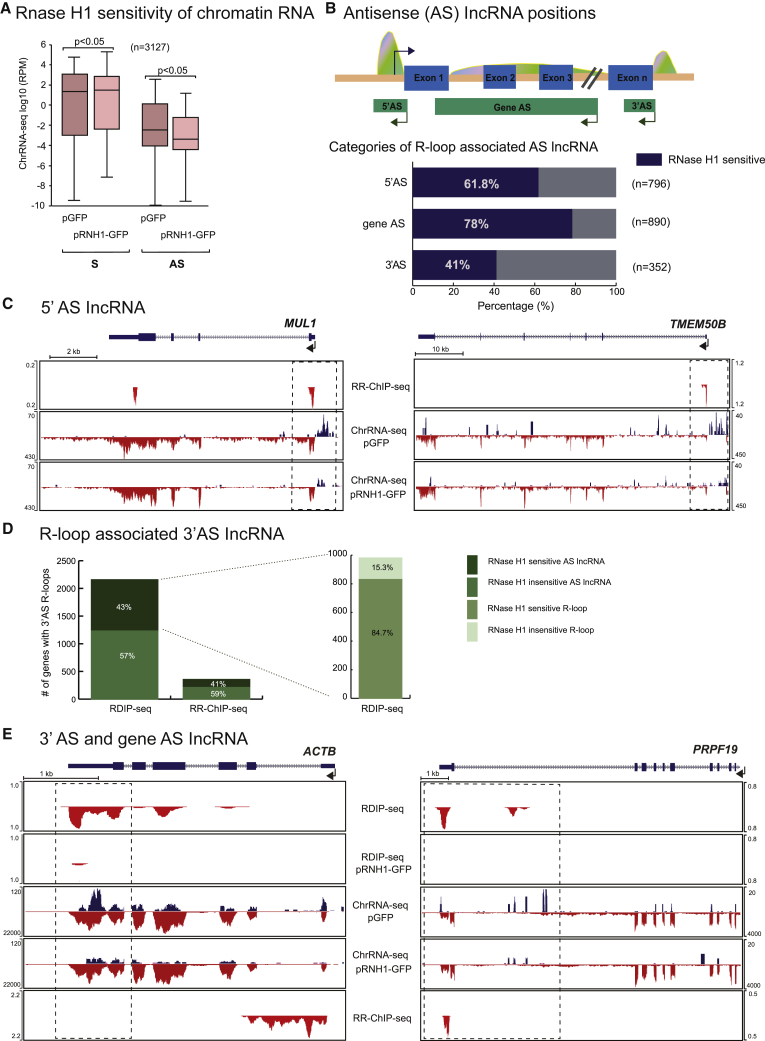
RNase H1-Sensitive AS Transcripts(A) Boxplots of ChrRNA-seq expression levels for 3,127 protein-coding genes in pGFP and pRNH1-GFP-positive cells. S and AS regions correspond to ±3 kb from TSS in the direction of transcription. p values were computed using the Wilcoxon test.(B) Diagram showing the positions of AS transcripts and associated R-loop peaks across schematic protein-coding gene (upper panel). Arrows denote transcription direction. Lower panel shows the number of AS transcripts derived from specific protein-coding genes that are positioned in a window of ±250 bp around the RR-ChIP peaks. Percentage of AS lncRNA that display RNase H1 sensitivity is indicated.(C) Specific examples of 5′AS lncRNA showing RNase H1 overexpression sensitivity in MUL1 and TMEM50B.(D) Stacked bar chart showing proportion of RNase H1 overexpression sensitive and insensitive transcripts overlapping with RDIP-seq or RR-ChIP-seq peaks within a region ±2 kb of annotated TES. Further breakdown (on the right) of RDIP-seq peaks overlapping RNase H1 overexpression sensitive transcripts that also show pRNH1-GFP sensitivity.(E) ACTB and PRPF19 show RNase H1 overexpression sensitivity in TES region.